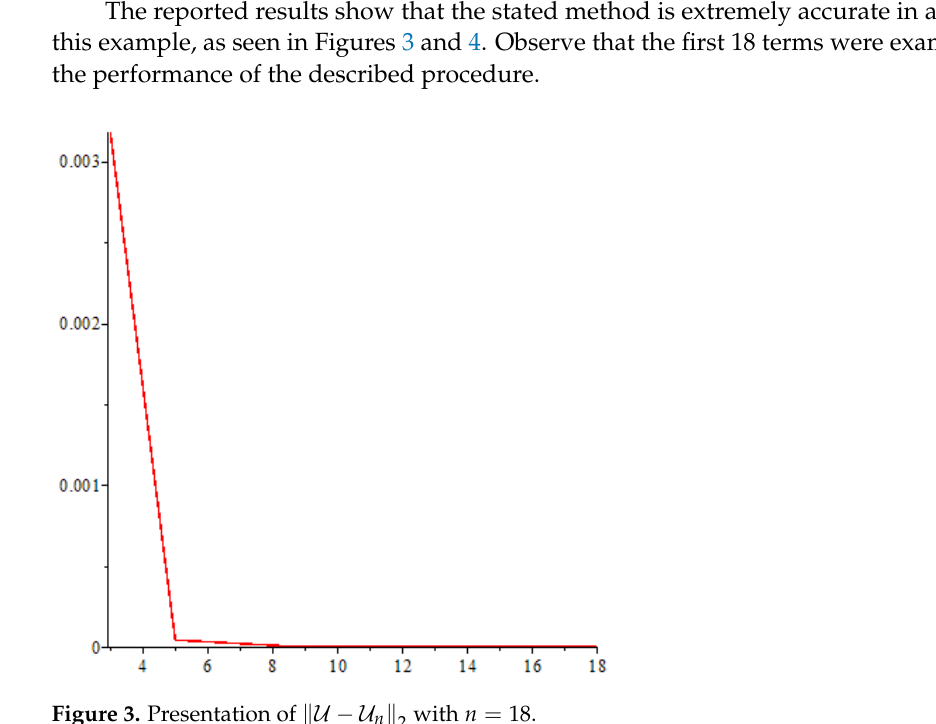
Figure 3. Presentation of (cid:107)U − U n (cid:107)